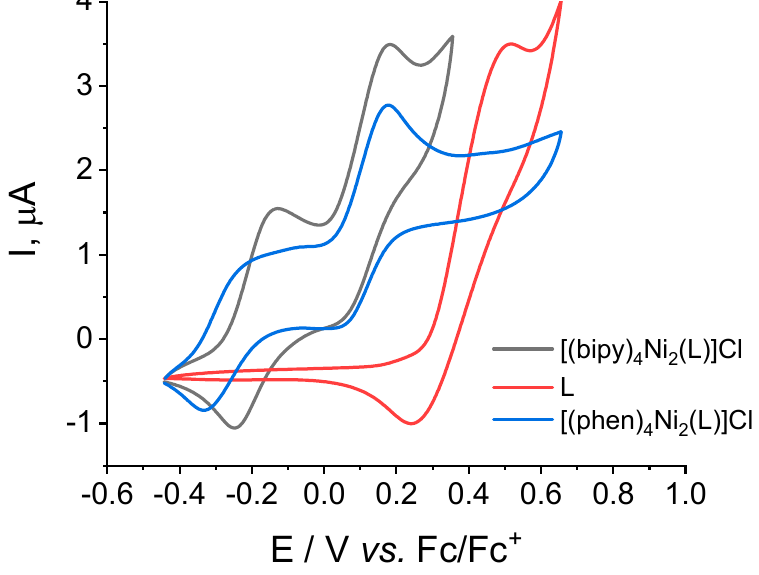
Figure 3. Cyclic voltammograms of the ligand L (red line) and of the complexes [(bipy) 4 Ni 2 (L)]Cl (black line) and [(phen) 4 Ni 2 (L)]Cl (blue line) in 0.1 M TBAPF 6 /CH 3 OH solutions at a scan rate of 0.10 V s − 1 . All potentials are referenced to ferrocene/ferrocenium (Fc/Fc + ) as an internal reference redox